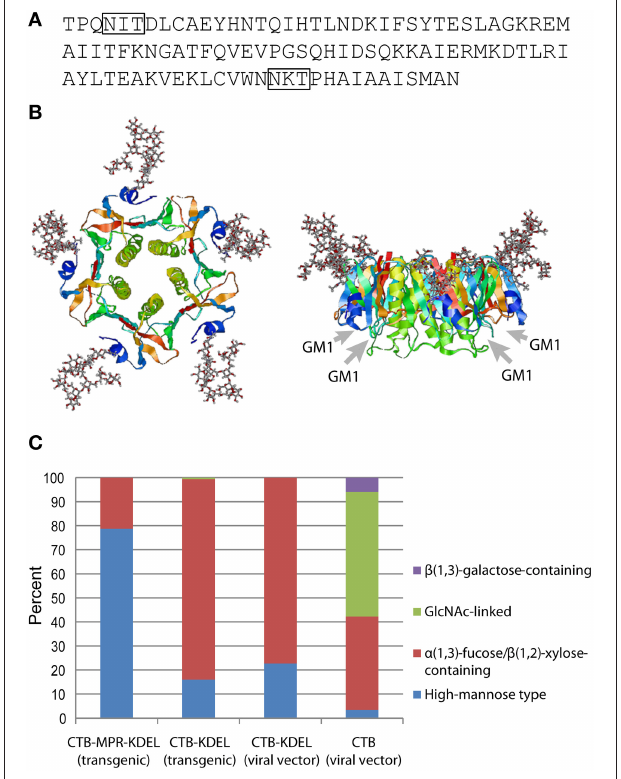
FIGURE 1 | N -Glycosylation of CTB. (A) Amino acid sequence of CTB from V. cholerae 569B strain (Protein Data Bank ID: 1FGB). N -Glycosylation sequons (Asn-X-Thr/Ser) are boxed. (B) Hypothetical structure images showing CTB homopentamer with high-mannose-type glycans attached to Asn4 positions. Images, top view on the left and side view on the right, were created by the Glyprot in silico protein glycosylation tool (http://www.glycosciences.de/modeling/glyprot/) based on the crystal structure of CTB (Protein Data Bank ID: 1FGB) and visualized by RasWin Molecular Graphics (ver. 2.7.5.2). Gray arrows show the positions of GM1-ganglioside-binding pockets. (C) Percent compositions of glycoforms attached to Asn4 of CTB, CTB-KDEL, and CTB-MPR-KDEL expressed in N. benthamiana . Data derived from Matoba et al. (2009), Hamorsky et al. (2013,